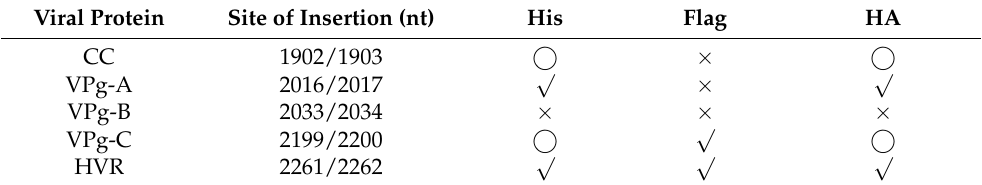
Table 2. Summary of rescue and tags expression of recombinant viruses harboring epitope tags.